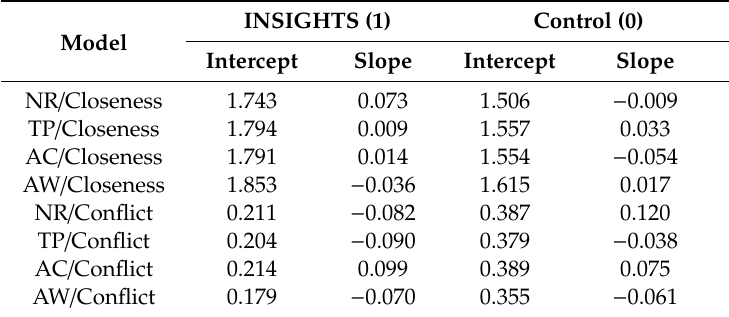
Table 6. Simple slopes and intercepts for T-SATI domain score predicting STRS domain score by experimental